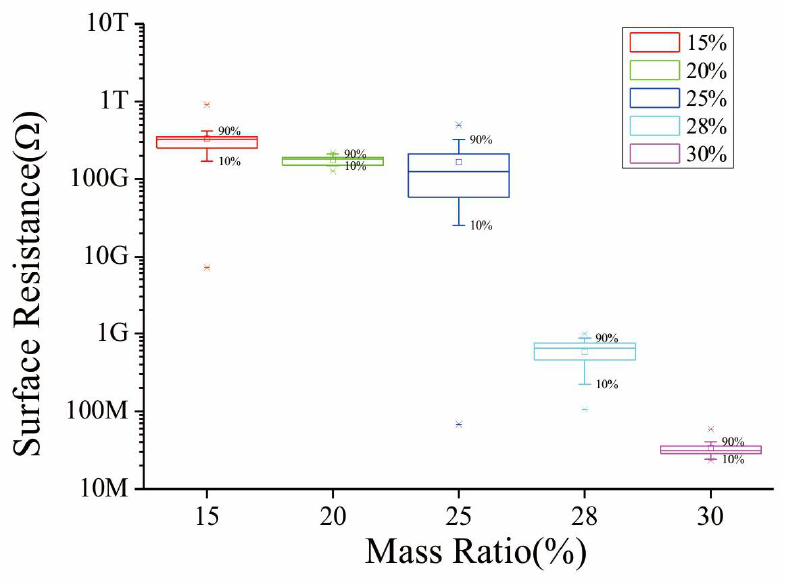
Figure 4. The surface resistance of one sensitive element (SE) with the mass ratio varying from 15% to 30%.